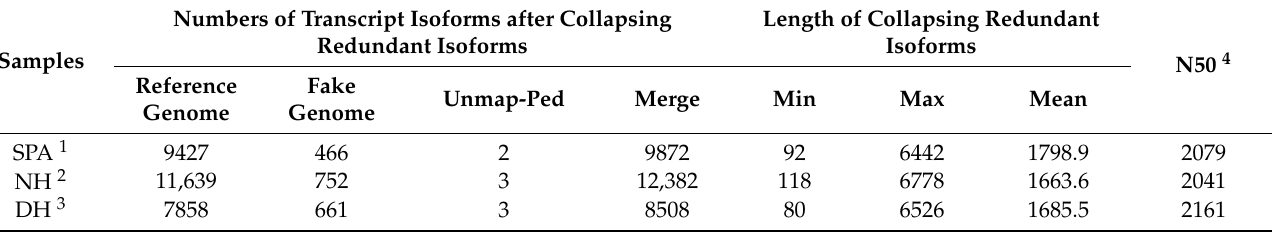
Table 2. Summary of features of transcript isoforms after collapsing redundant isoforms with cDNA cupcake, cogent, and